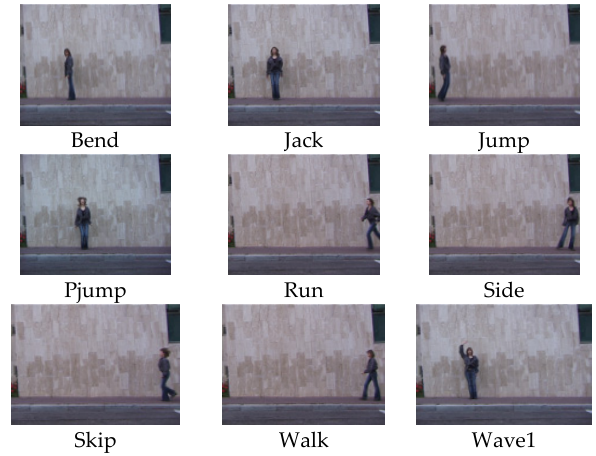
Figure 11. One frame example of each action in Weizmann dataset.